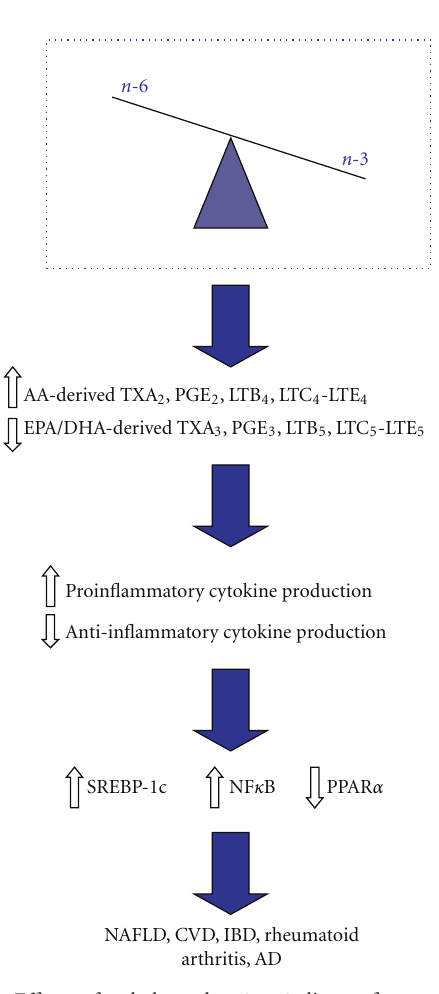
Figure 2: E ff ects of unbalanced n-6:n-3 dietary fatty acid intake on development of various diseases of inflammation. Dietary imbalance in the consumption of n-6 and n-3 PUFA,